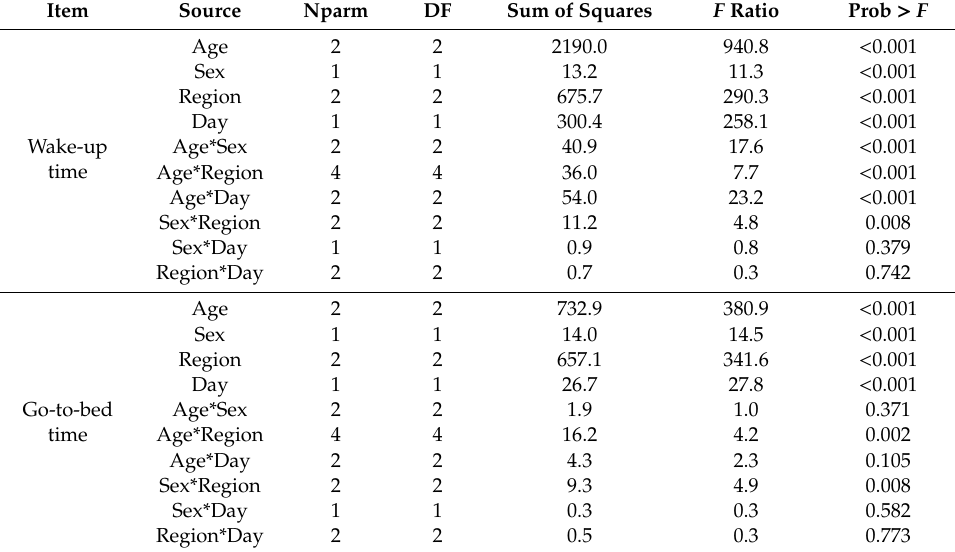
Table 9. Analysis of variance for the e ff ects of age ( < 30, 30–60, > 60 years), sex (male, female), living region (northern, central, and south), and day (weekdays and weekends) on wake-up and go-to-bed time.